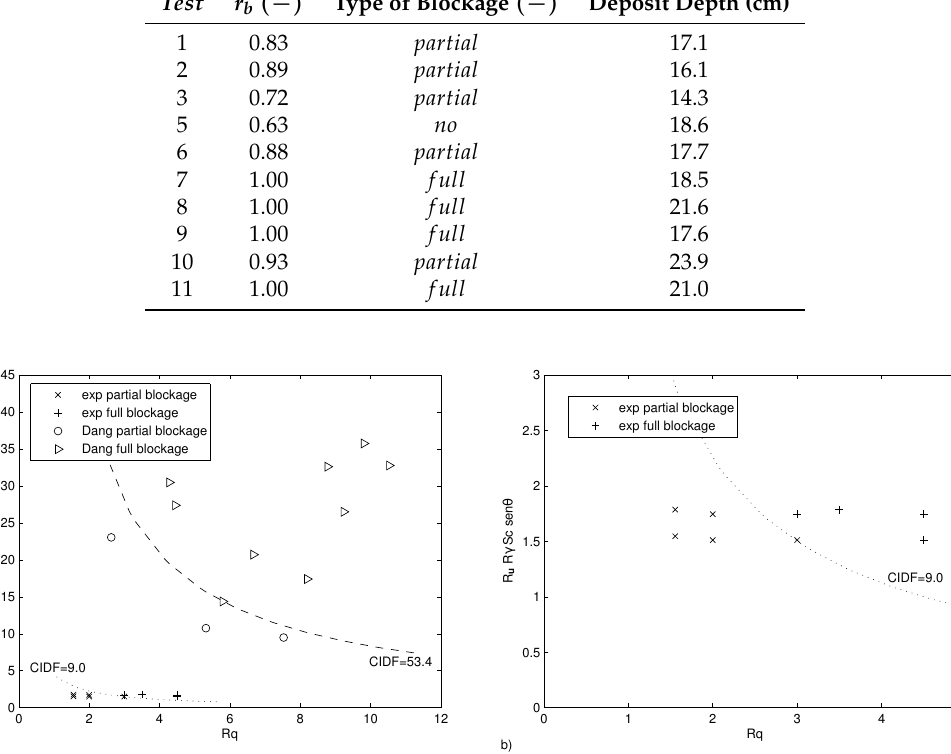
Figure 6. Blockage analysis of a main channel due to one lateral debris flow injection based on the debris flow and water discharges according to the approach of Dang et al. [8]: ( a ) data from Dang et al. [8] and from the experimental campaign; ( b ) focus on the experimental data. The dashed lines are the threshold values of the CIDF index indicating the partial blockage conditions respectively individuated for the two experimental